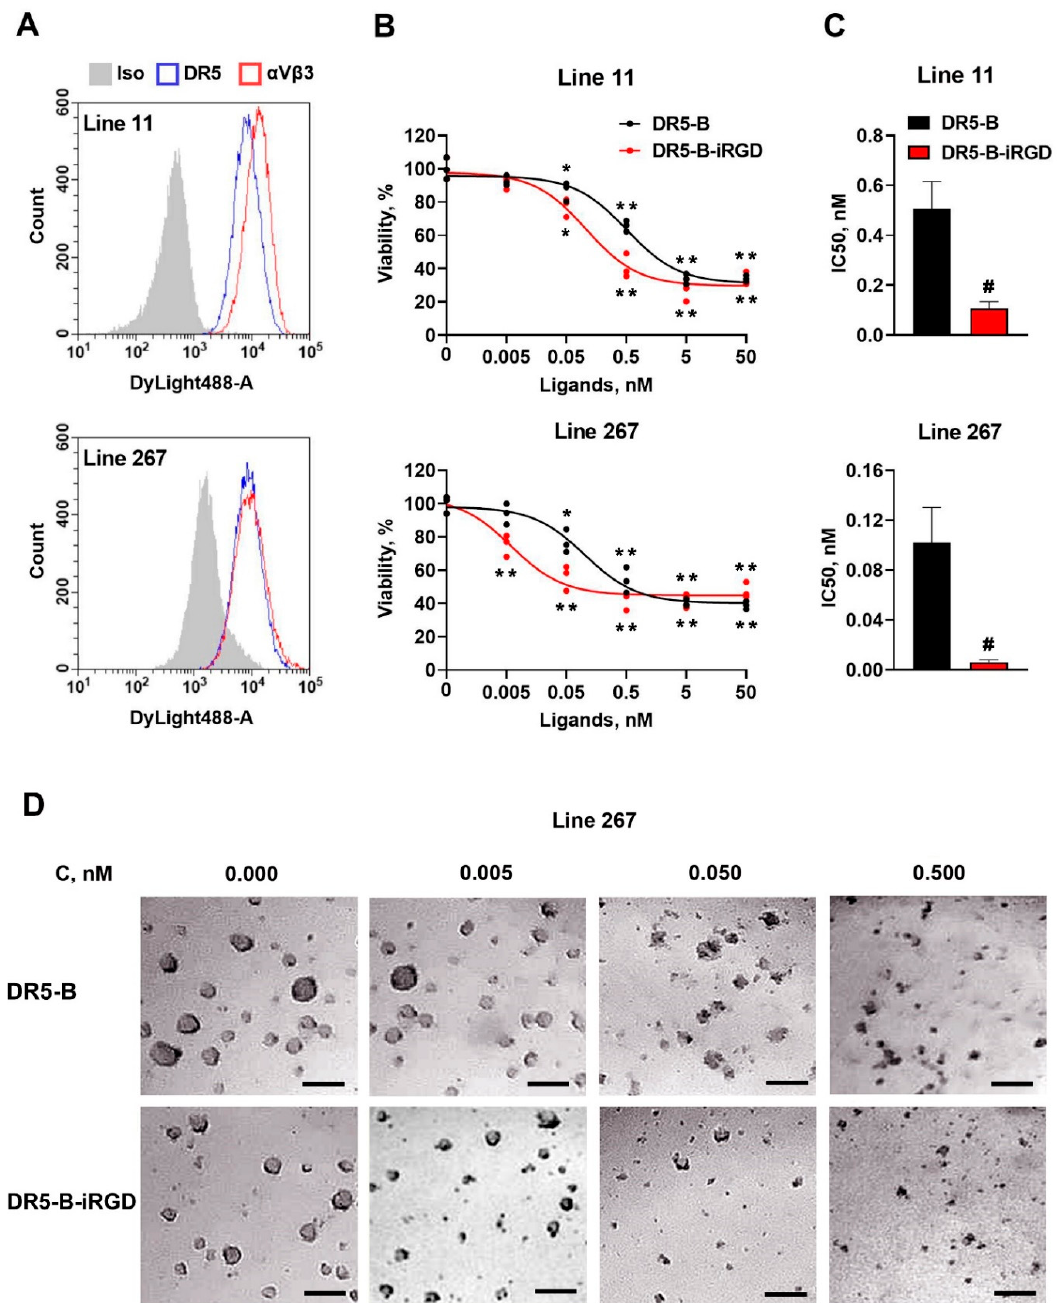
Figure 4. Cytotoxicity of DR5-B and DR5-B–iRGD in primary human glioblastoma patient-derived neurospheres. ( A ) Surface expression of the DR5 and integrin α v β 3 receptors determined by flow cytometry. ( B ) Primary human glioblastoma cell lines 11 and 267 were incubated with DR5-B or DR5-B–iRGD for 72 h, and viability was analyzed by the Alamar Blue assay. The data were displayed as mean ± SD from at least three replicates. * p < 0.005 and ** p < 0.0005 indicate significant difference from the control according to one-way ANOVA followed by Dunnett’s post hoc test. ( C ) IC50 values of DR5-B and DR5-B–iRGD were determined as the drug concentrations resulting in the 50% inhibition of cell growth by nonlinear regression in GraphPad Prism 8 software. # p < 0.005 indicate significant difference from the control according to Student’s t-test. ( D ) Morphology of primary patient-derived neurospheres (Line 267) treated with DR5-B or DR5-B-iRGD. Scale bar is 200 µ m.